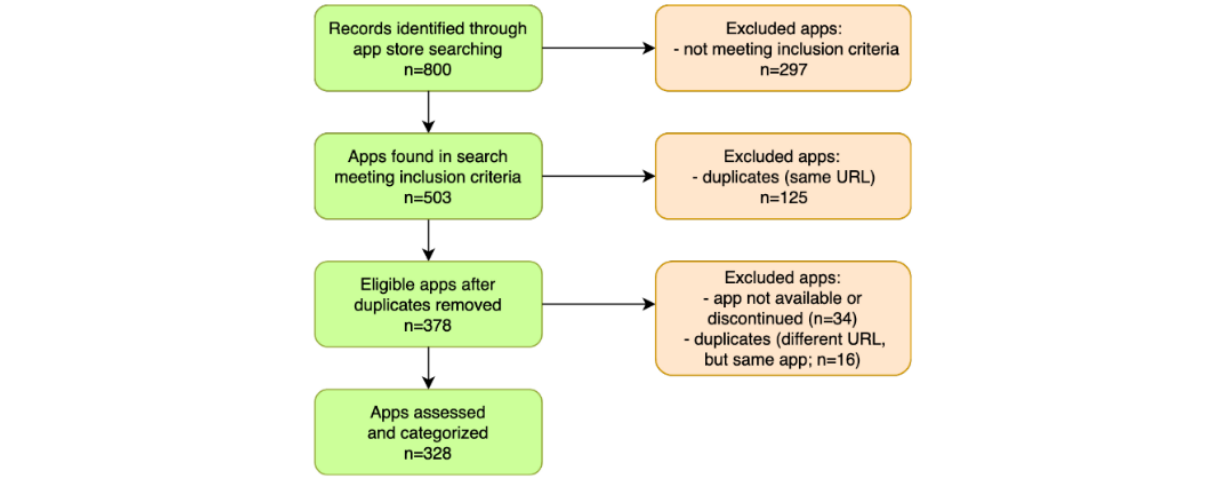
Figure 1. Diagram illustrating the review process and exclusion of apps at various stages of the study.